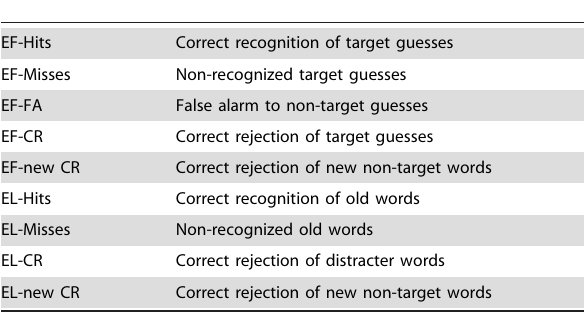
Table 3. Description of experimental categories.